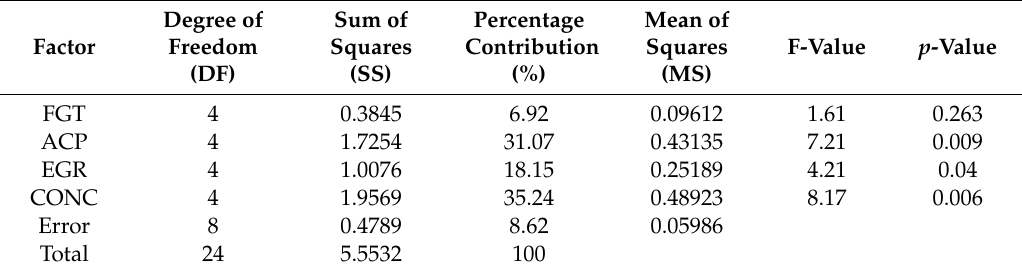
Table 7. ANOVA table for the mean